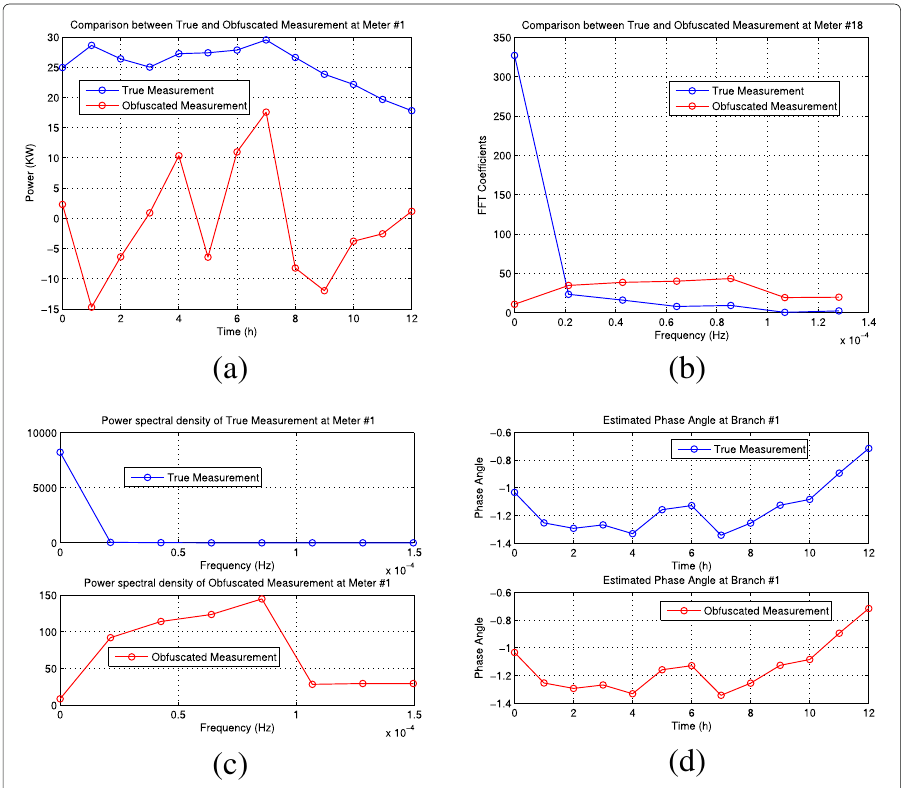
Fig. 4 Illustration of data Obfuscation in a 5-bus power network. a Original and Obfuscated Time Domain Data from Meter #1. b Original and Obfuscated Frequency Domain Data from Meter #1. c Power Spectral Density of True and Obfuscated Measurement Data. d Estimate State Value at Branch #1. Estimation error between true and obfuscated dataset =